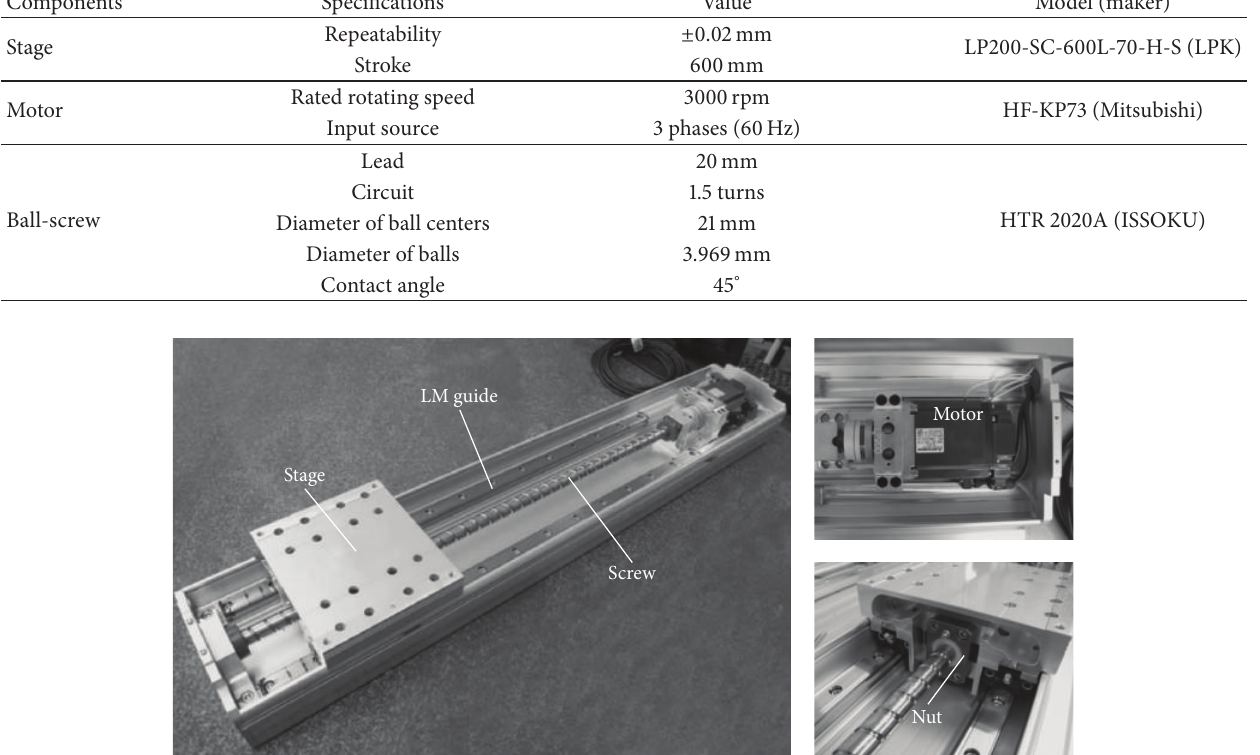
Figure 5: Ball-screw-driven